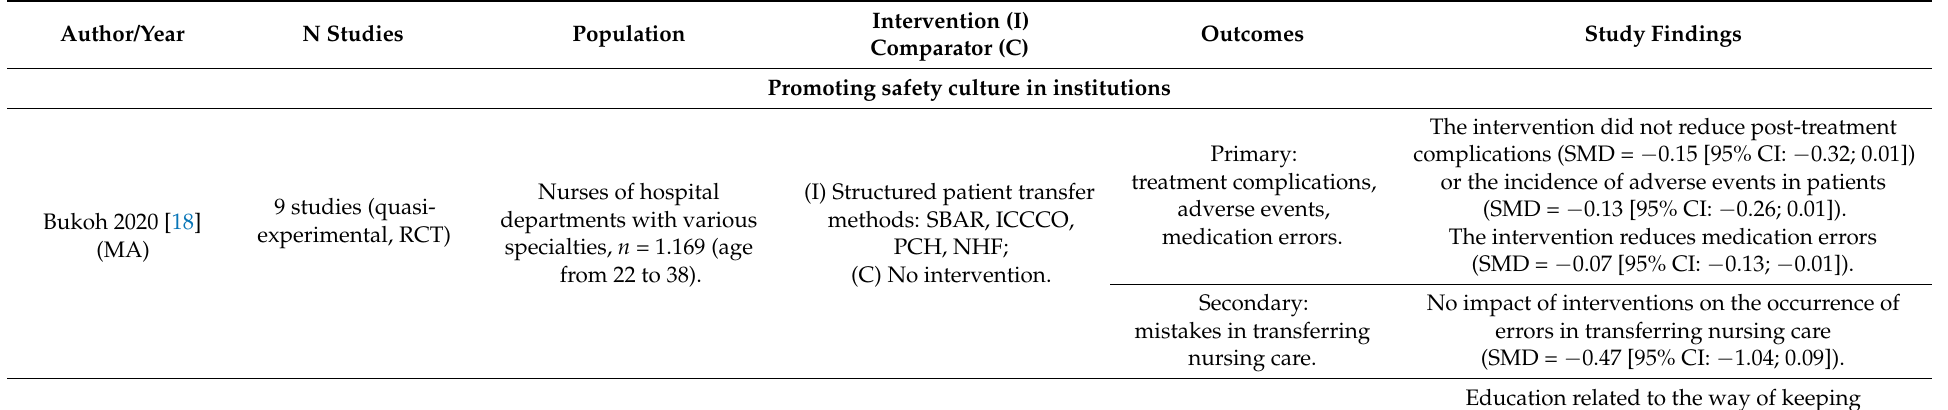
Table 2. Summary and intervention characteristics of the included